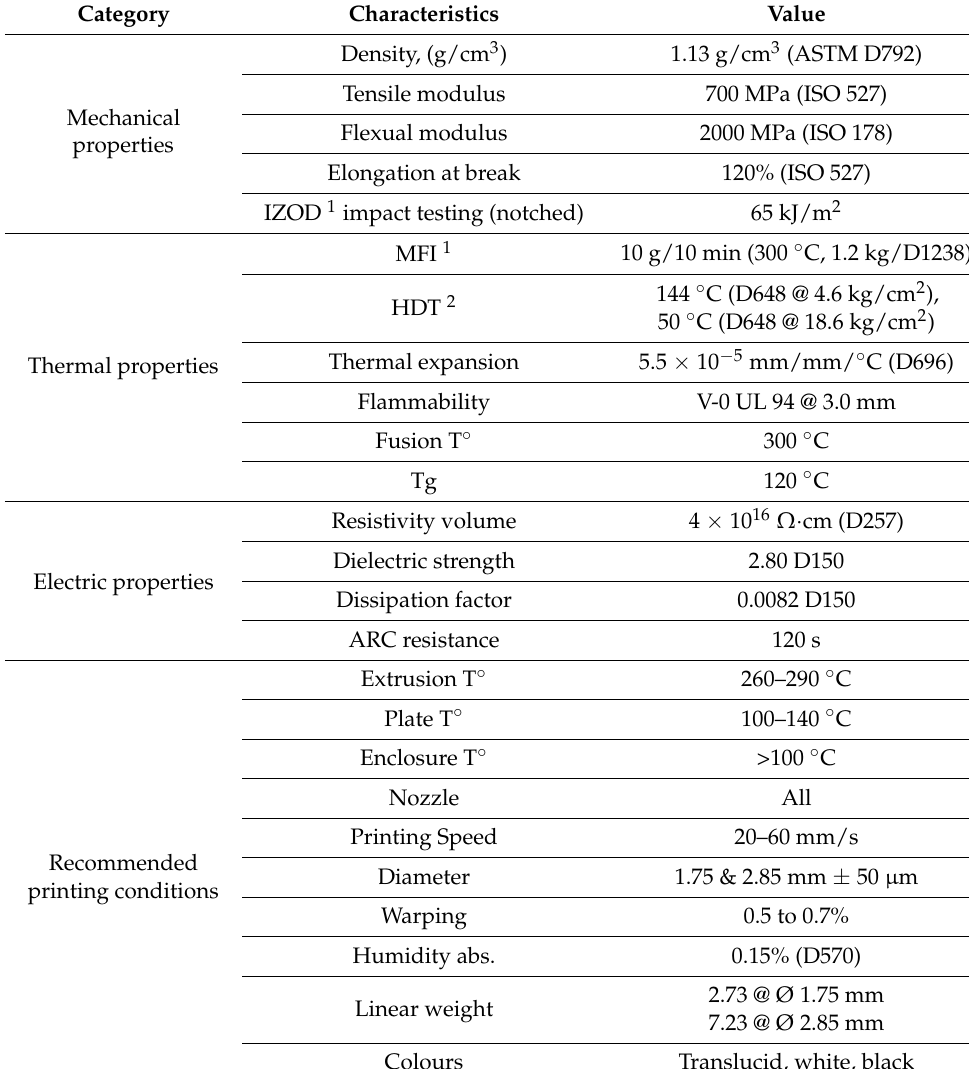
Table 1. Recommended printing conditions and properties of PC feedstock